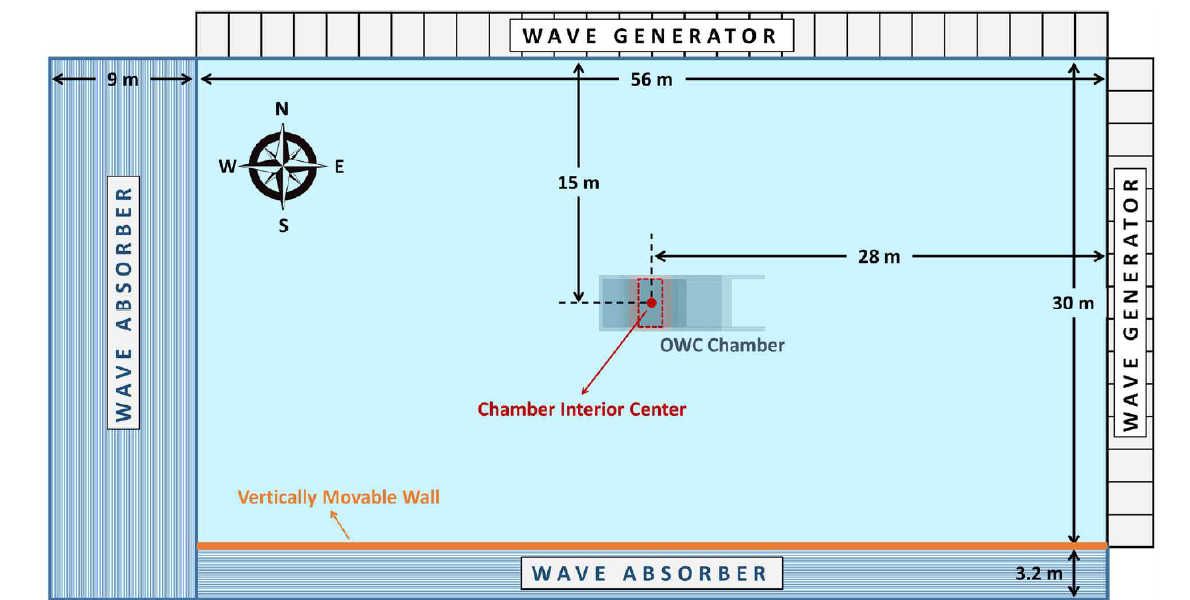
Figure 1. The Korea Research Institute of Ships and Ocean Engineering (KRISO) wave basin where the tests were